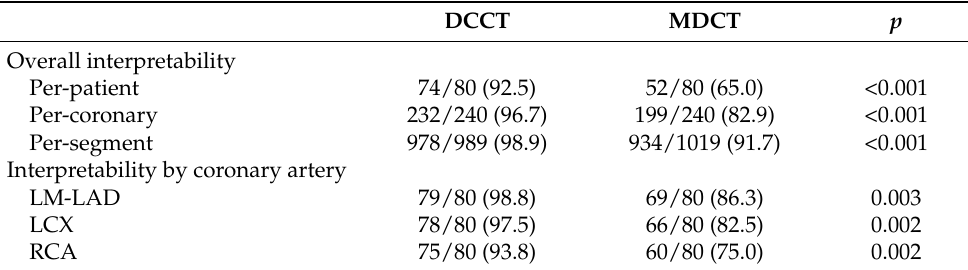
Table 2. Detailed assessment of